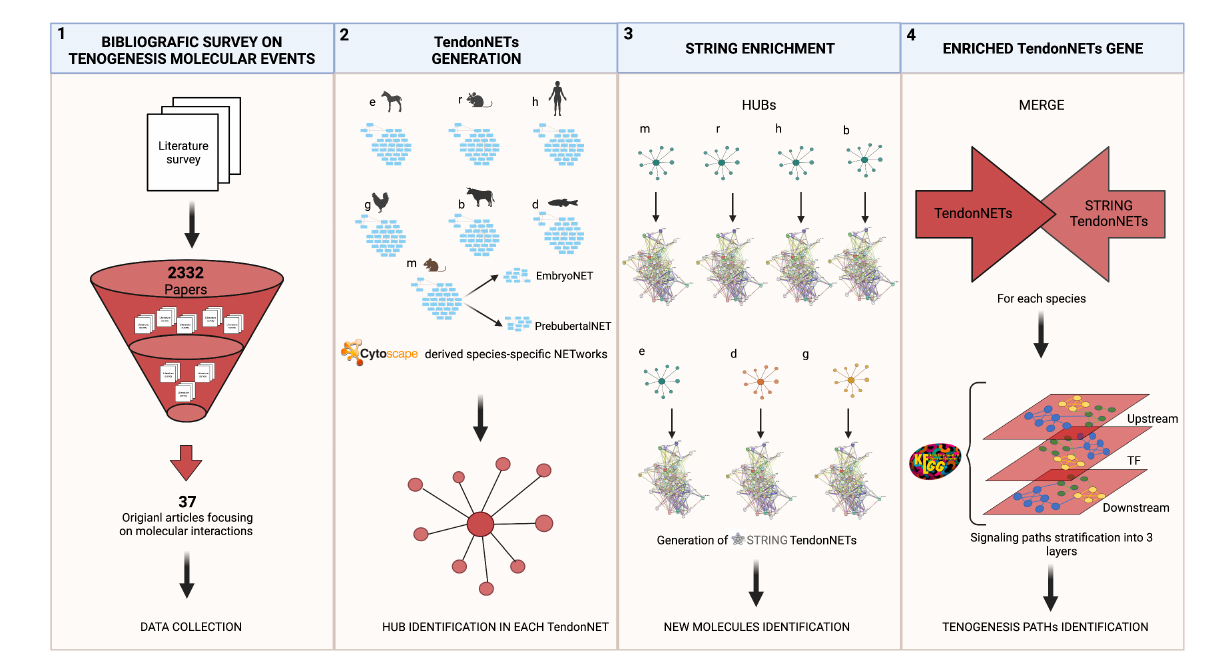
FIGURE 1 The methodological flow of the study. The study recognizes a stepwise approach focused on four main tasks: (1) The bibliographic survey performed by accessing Web of Science collection related to tenogenesis molecular events aimed to the selection of pertaining publications and data collection; (2) TendonNET generation was based on literature evidence and aimed to build up species-specific interaction networks supporting tenogenesis and to identify hubs (hyperlinked nodes) of each species-specific network. Species-specific networks and hub identification were obtained by using the Cytoscape tool. Only data collected from the Mus musculus (m) were also processed by distinguishing networks of interactions occurring during the embryo and prepubertal developmental phase; (3) the hubs of each species-specific TendonNETs were used as input for the generation of networks of new interactions of the tenogenesis (STRING TendonNETs) by using the STRING tool; (4) finally, combining interactions collected by literature evidence (TendonNETs) with potential new interaction (STRING TendonNET), species-specific enriched networks (Enriched TendonNETs) were generated. The organization of signaling events was then investigated by stratifying signaling paths supporting tenogenesis into three interconnected layers, such as upstream, processing TF (Transcription factors), and downstream. Specific abbreviations were used for each model organism (otherwise referred to as species). Mus musculus (m), Rattus norvegicus (r), Homo sapiens (h), Equus caballus (e), Bos taurus (b), Gallus (g), and Danio rerio (d). Created with